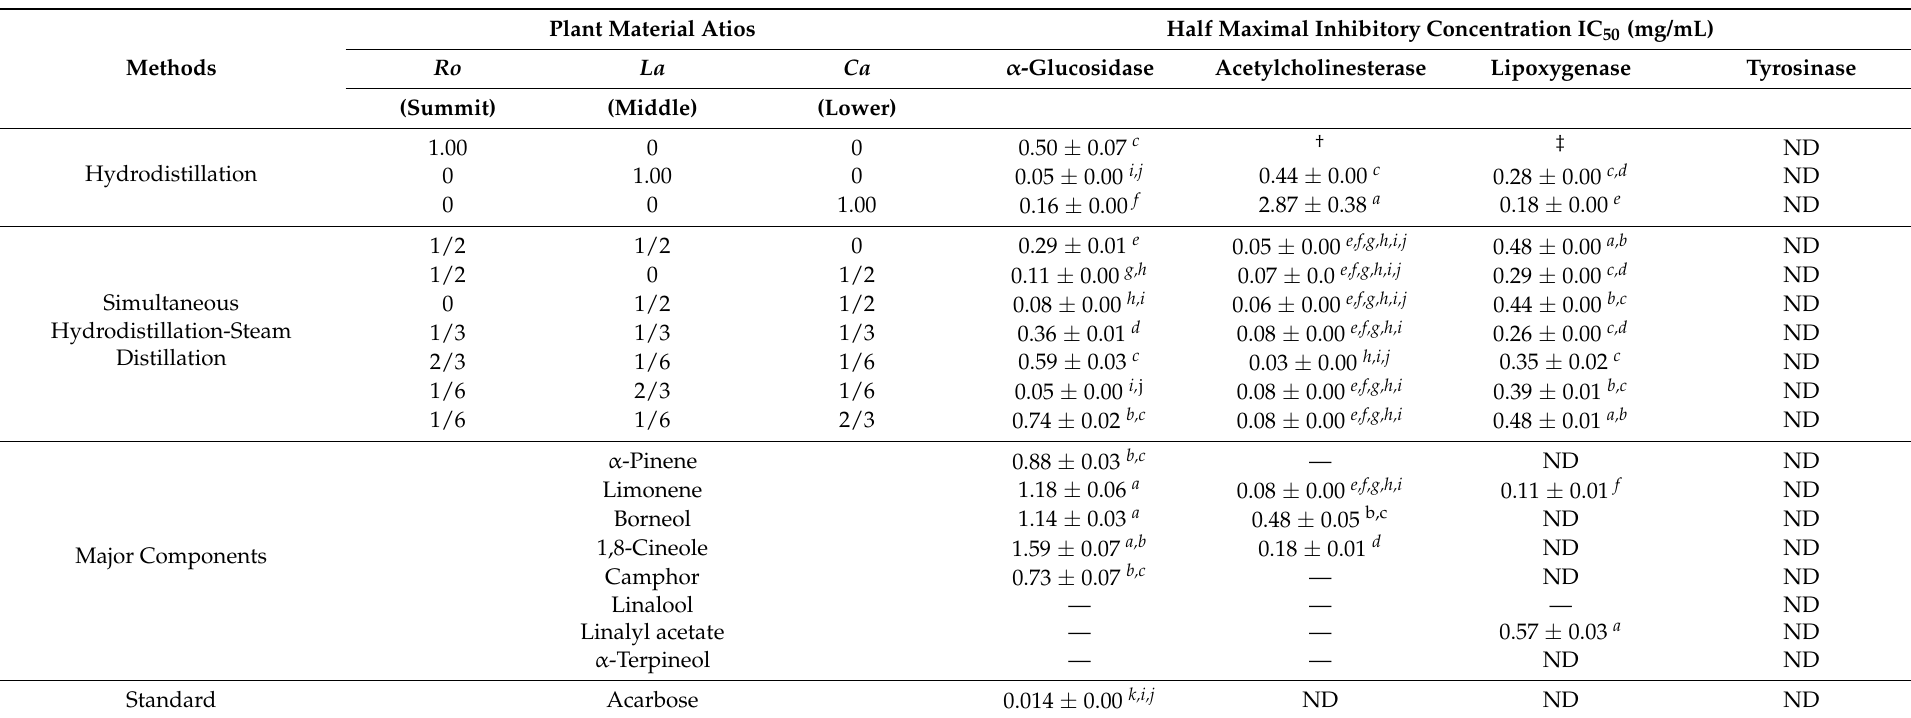
Table 4. Enzymatic inhibitory activity of sample EOs extracted by hydrodistillation and simultaneous hydrodistillation–steam